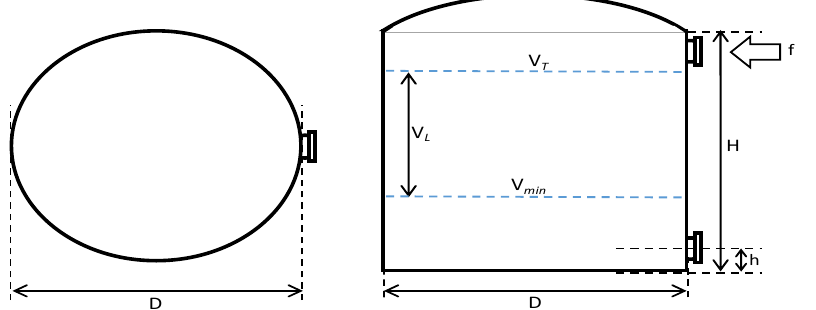
Figure 1. B20 fuel storage tank with variation in storage capacity (VT), dimensions (H/D ratio), discharge piping level (h), the volume of minimum fuel stock (Vmin), and ‘fresh’ B20 fuel loaded into the tank (VL). Table 1. B20 storage tank conditions for simulation of sludge removal schedule from fuel storage